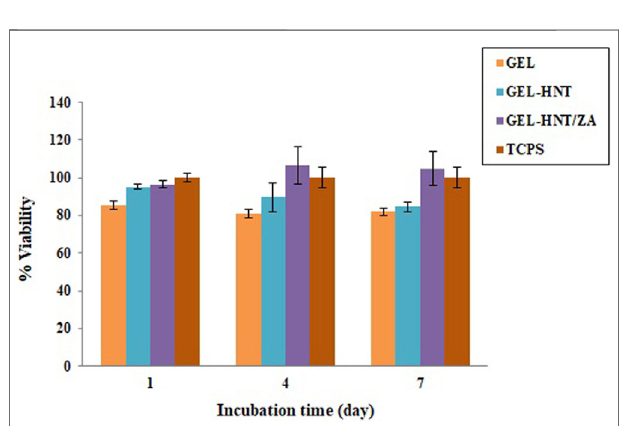
FIGURE 6 | MTT assay of hASCs cultured on the scaffolds ( p < 0.05).